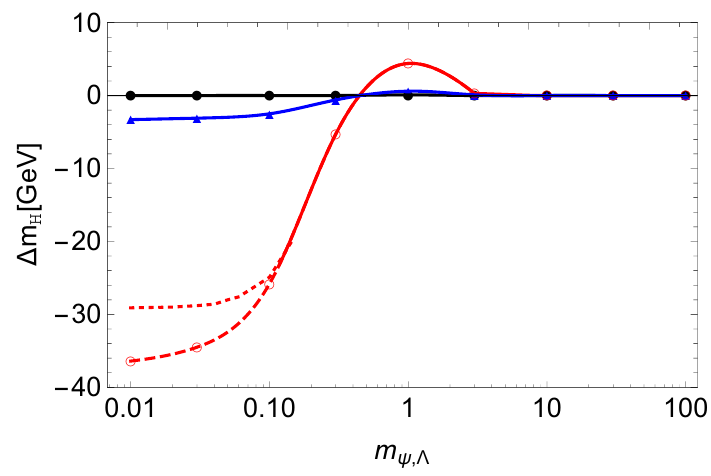
Figure 1 . Relative shift of the Higgs mass from the conventional lower mass bound as a function of the dimensionless dark fermion mass parameter at the cuto(cid:11) scale for (cid:3) = 10 5 GeV. The black curve with black (cid:12)lled circles denotes values for (cid:21) h ; (cid:3) = 0 : 1. The blue curve with triangles and the red curve with empty circles show results for (cid:21) h ; (cid:3) = 1 and (cid:21) h ; (cid:3) = 3, respectively. Solid lines indicate that the shift can be obtained without introducing a metastability in the e(cid:11)ective Higgs potential. A second minimum is present in the e(cid:11)ective potential for dashed curves. The dotted branch depicts a shift in the Higgs mass with stable potential which is stabilized by a nonvanishing scalar sector in the